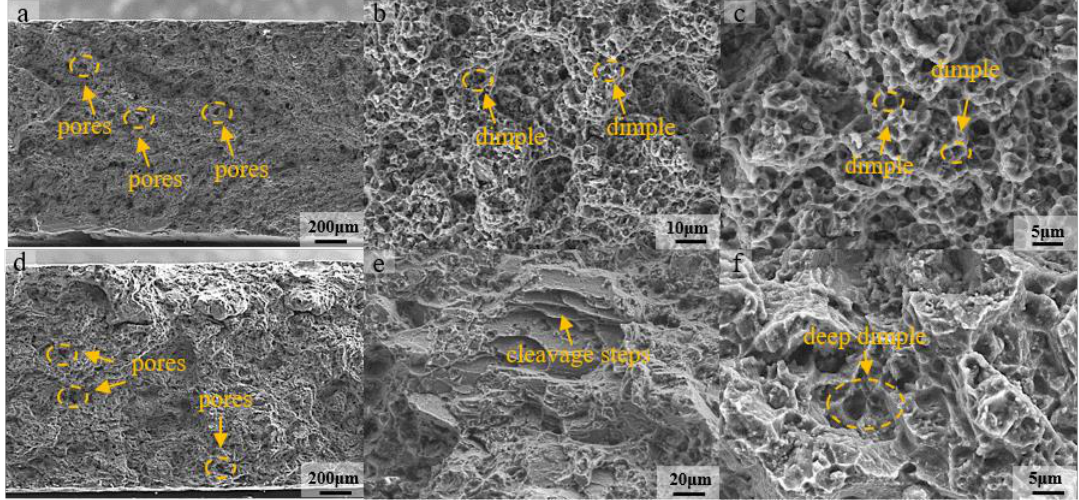
Figure 7. Fracture morphology at different T4 temperatures: ( a – c ) 330 °C; ( d – f ) 410 °C.